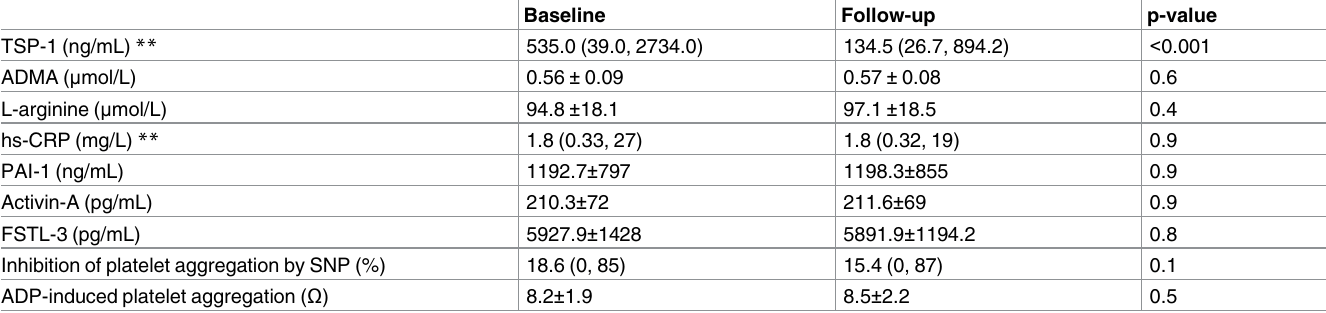
Table 2. Effects of vitamin D supplementation on changes of nitric oxide, inflammation, and fibrotic